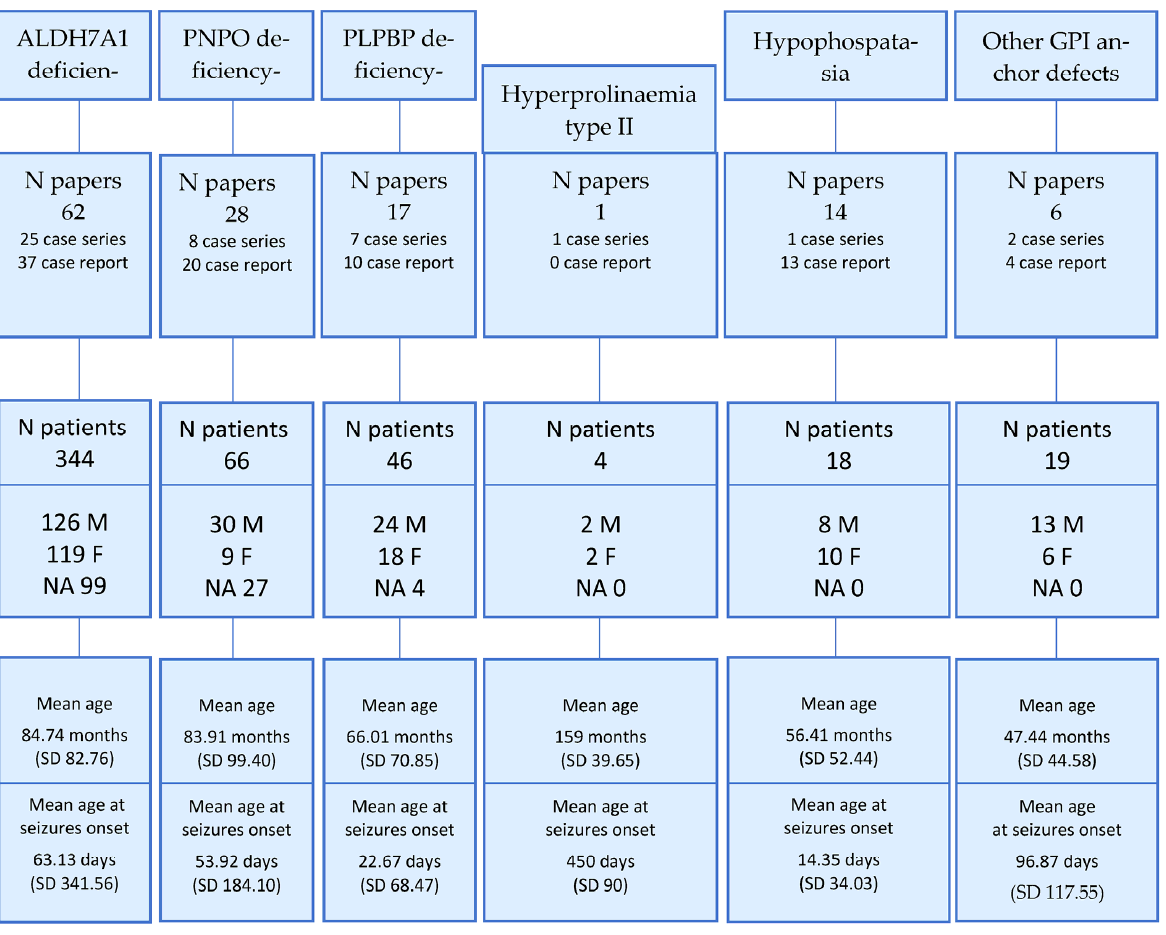
Figure 1. Flowchart reporting the selections of articles for this review.